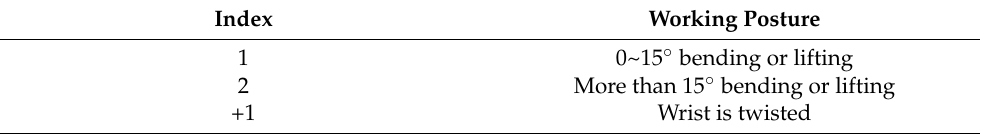
Table 11. Classification based on the wrist.